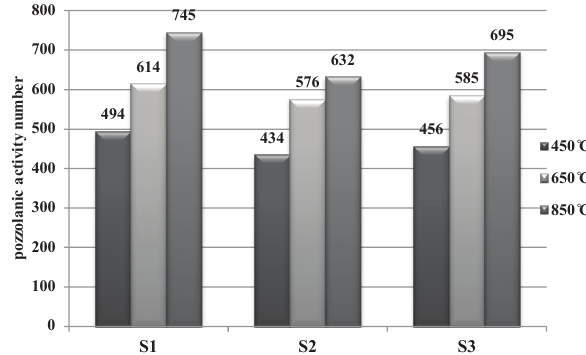
Figure 6. Pozzolanic activity numbers of clay soils treated at different temperatures Figure 6: Pozzolanic activity numbers of clay soils treated at different temperatures.